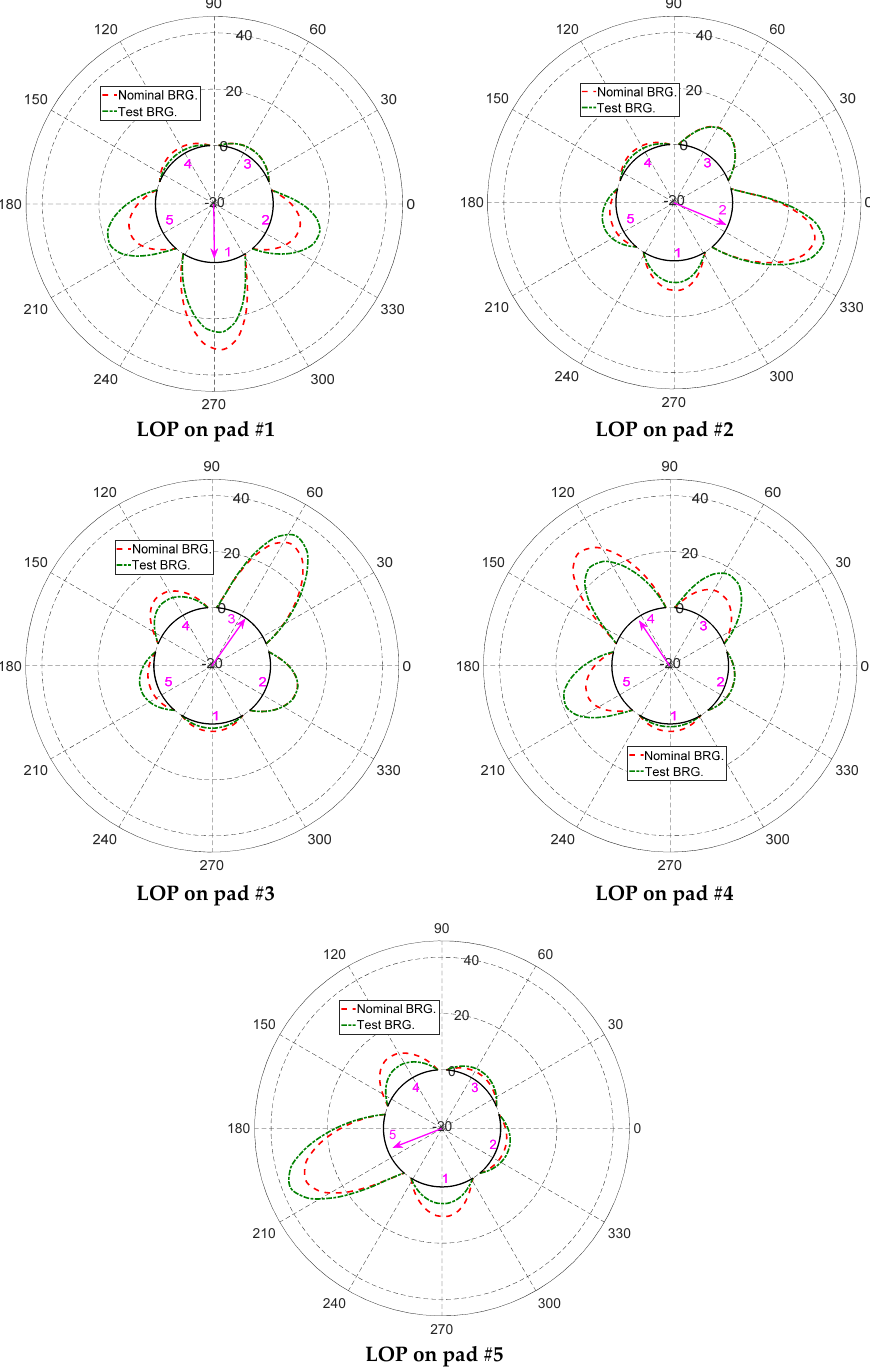
Figure 21. Predicted pressure distribution with LOP configuration on each pad of nominal bearing vs. tested bearing.